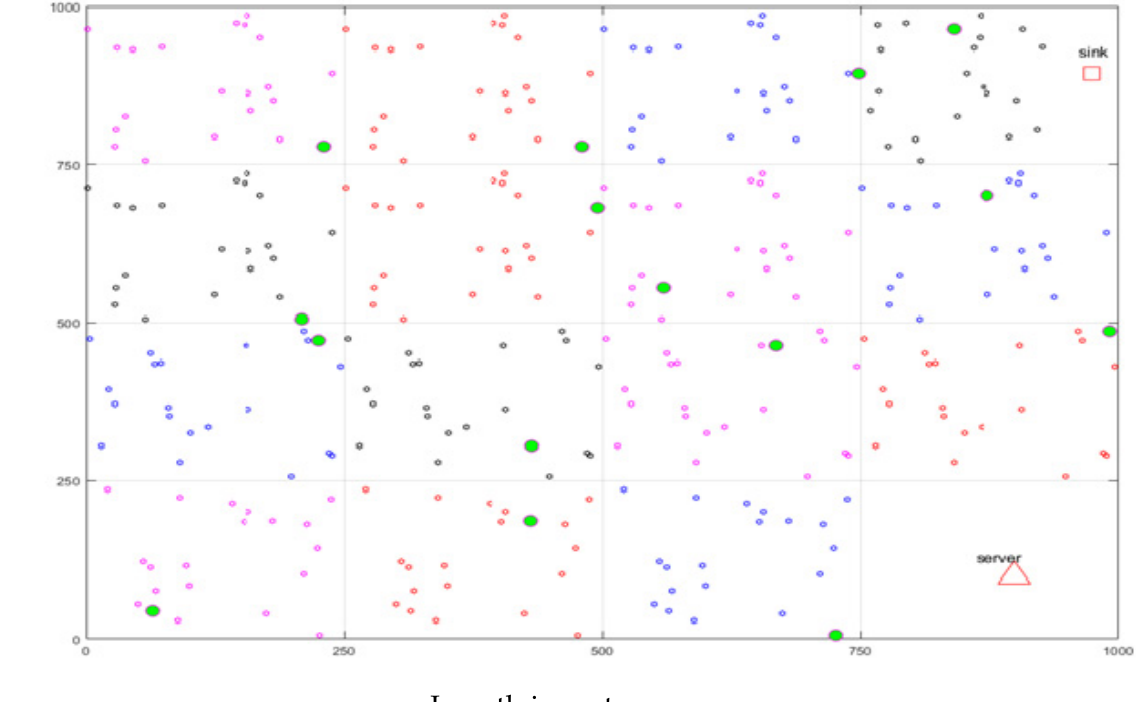
Figure 6. Formation of Grid Using the Deployed Nodes.